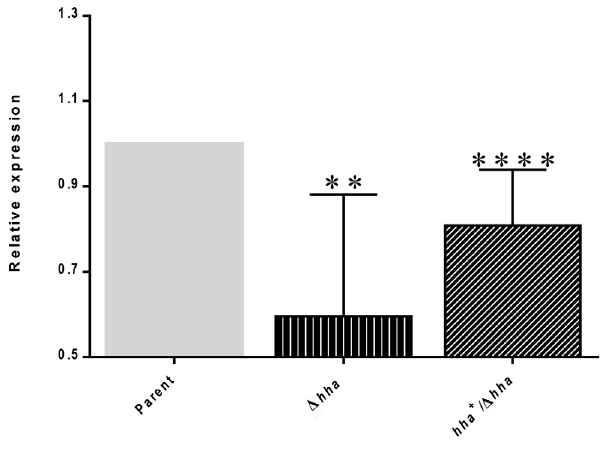
Figure 4. Transcriptional activation of qseC by Hha. The effect of hha on the transcription of qseC was determined by a QRT-PCR assay using a DNA-free RNA prepared from bacterial strains grown in DMEM for 5 h to an A 600 of 1.1 to 1.2. The relative expression of qseC in the parent, hha ( D hha ), and hha -complemented ( hha + / D hha ) mutant strains is shown in the bar graph as means 6 SEM of three independent bacterial cultures and nine technical replicates. Significant ( p , 0.05) differences in qseC transcription between the parent and mutant strains were determined using Mann-Whitney test. ** ( p =0.0019); **** ( p = , 0.0001).